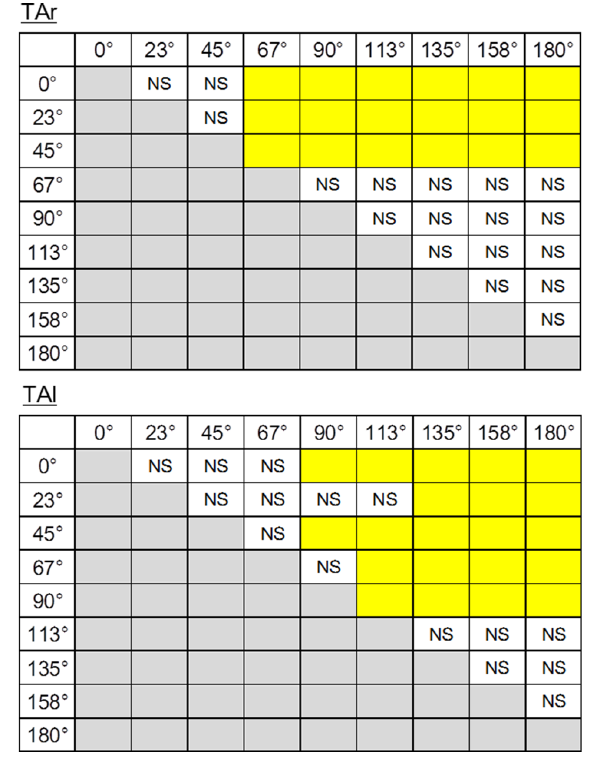
FIGURE 7 | The results of post hoc tests on ARV of electromyographic activity during the APA phase of TAr (top) and TAl (bottom). The pairs shown in the columns colored in yellow show significant differences ( P < 0.05). NS, non-significant.